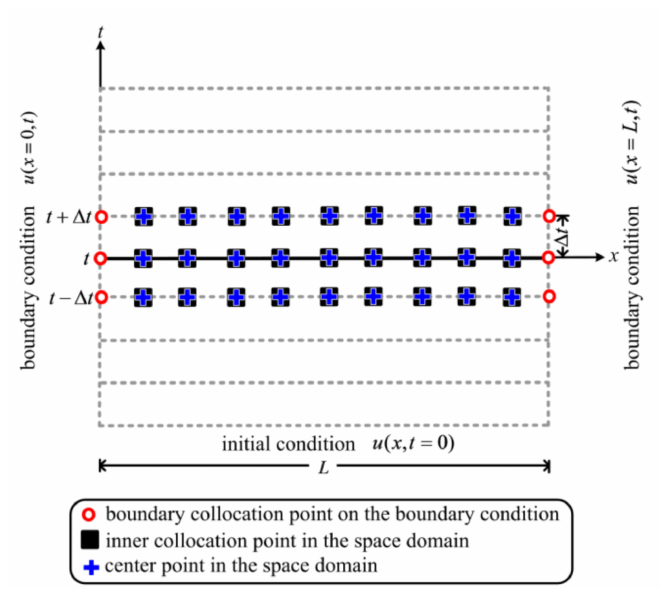
Figure 1. Configuration of the collocation points for the direct heat conduction